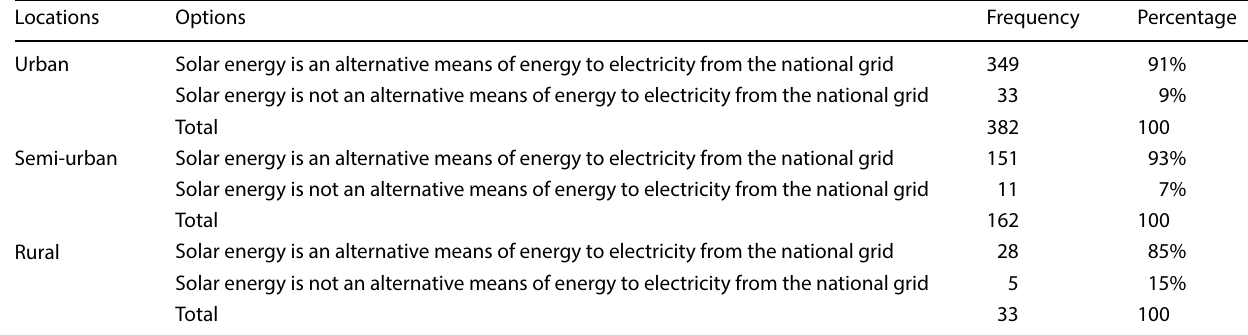
Table 3 Cross tabulation of solar energy as an alternative to electricity from the national grid